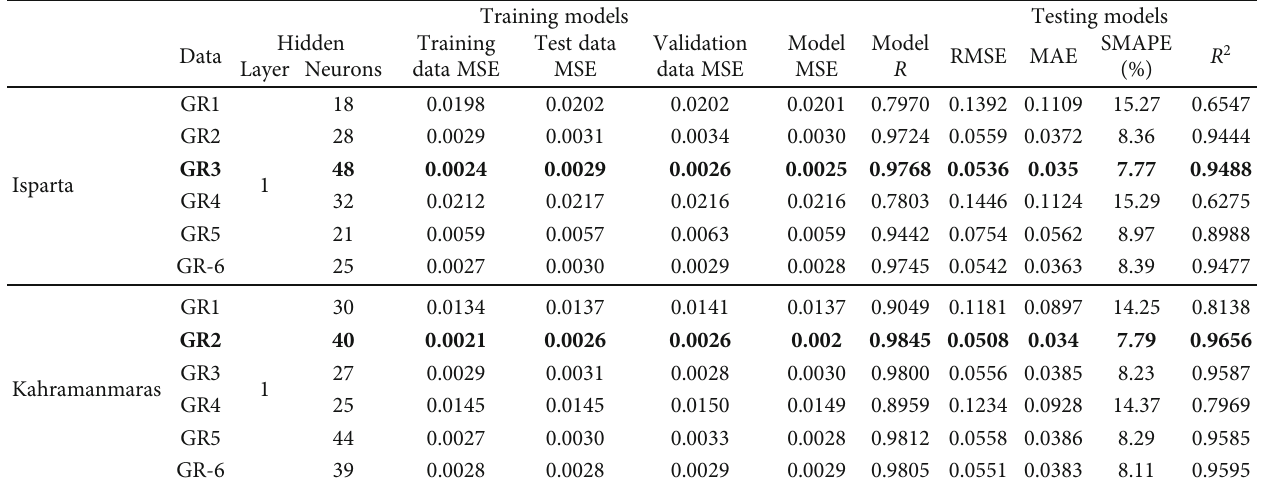
Table 8: Training and test estimation results of the most successful models that were developed by using the MFFNN algorithm according to input data groups of both provinces.